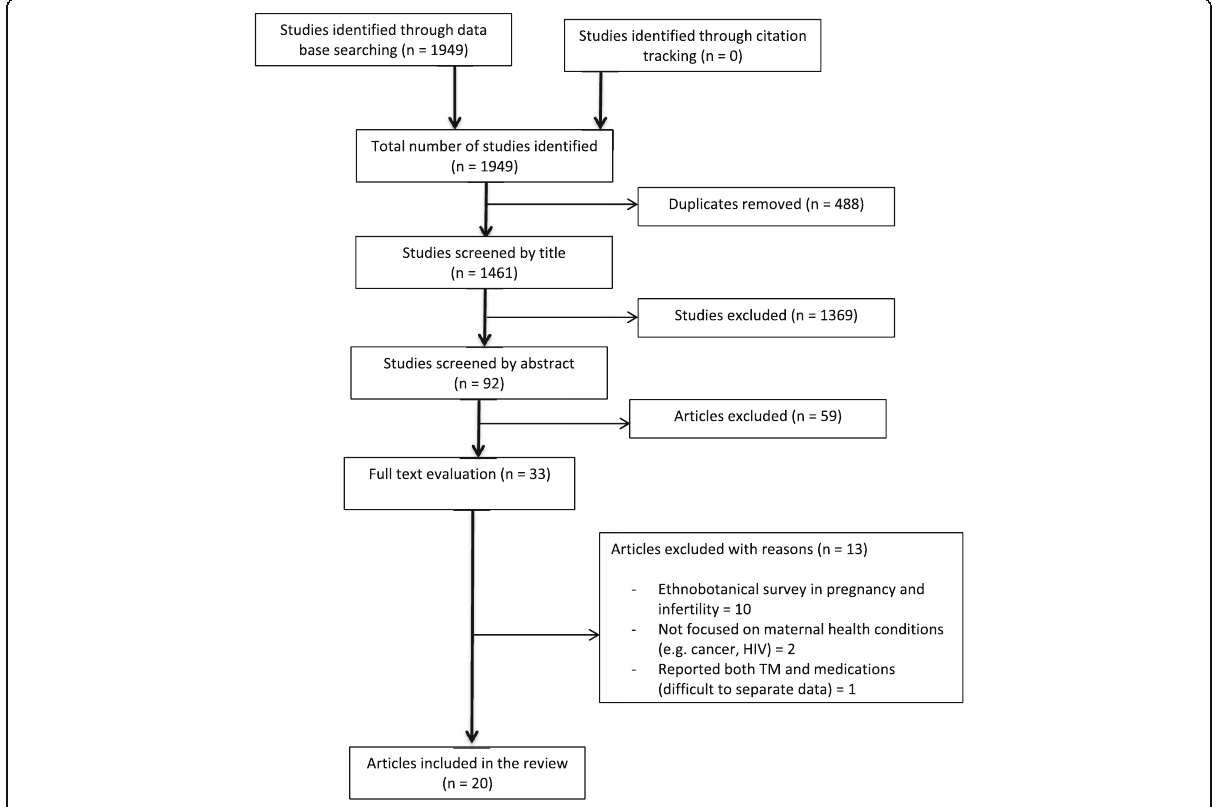
Fig. 1 PRISMA flow chart of included and excluded